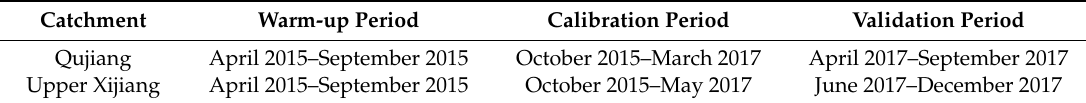
Table 2. Periods for warm-up, calibration, and validation for Qujiang and Upper Xijiang